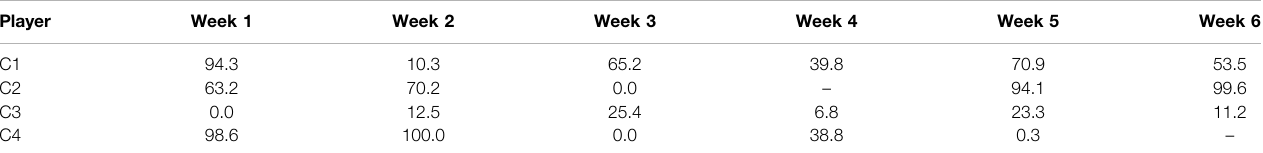
TABLE 2 | Percentage of play time at or above target heart rate by participant and week. Data for participant C5 is not shown, as they had only minimal participation in the study (see Table 1 ).